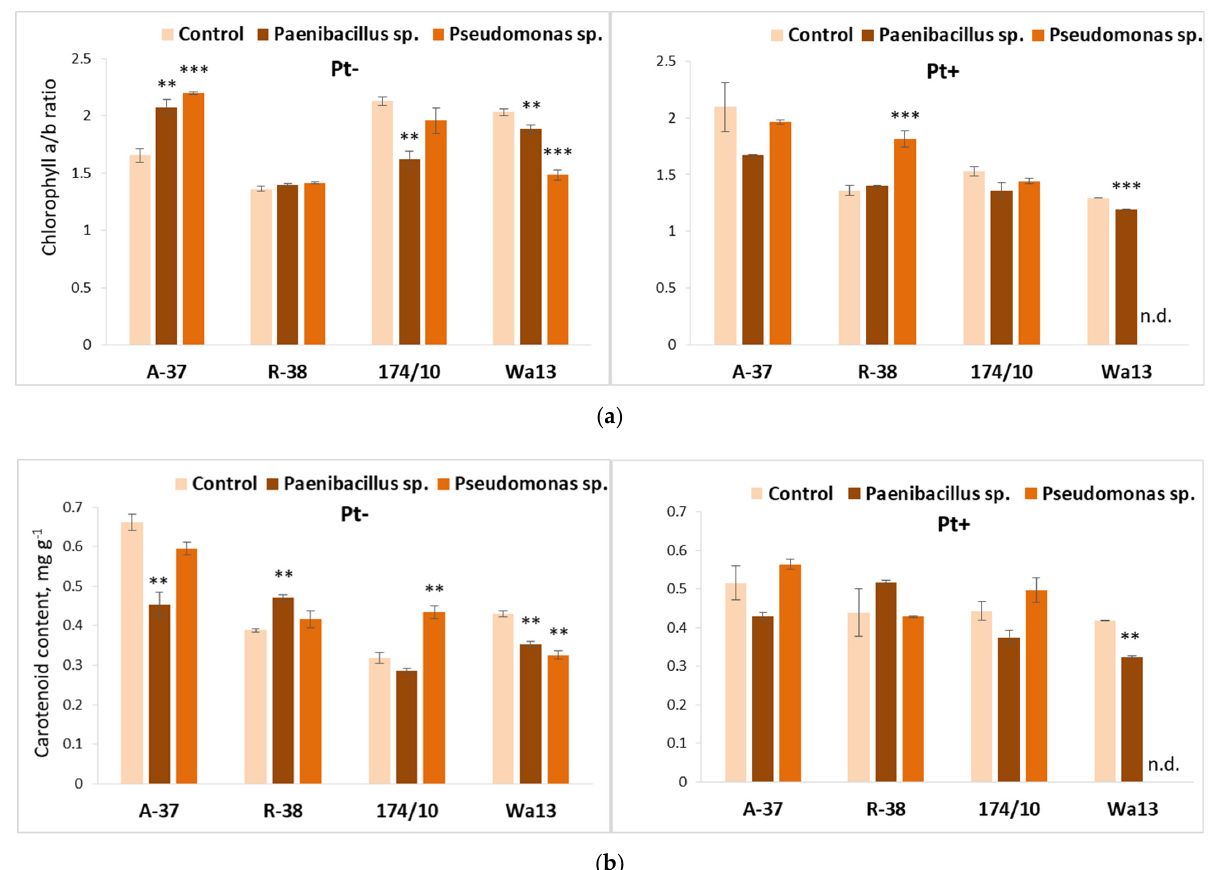
Figure 8. Average chlorophyll a/b ratio ( a ) and carotenoid content ( b ) in the leaves of different Populus genotypes (A-37 and R-38, P. tremula ; 174/10 and Wa13, P. tremula × P. tremuloides ), whose explants were first cultured on the nutrient medium inoculated with Paenibacillus sp. or Pseudomonas sp. bacteria, then transferred onto fresh nutrient medium, either sterile (‘Pt − ’) or inoculated with fungus Phellinus tremulae (‘Pt+’). Statistically significant differences from the control variant, which was not treated with bacteria during the first culture stage, are indicated (for each genotype separately): ** p < 0.01; *** p < 0.001. ‘N.d.’ means that, because of decreased explant viability, no reliable data were obtained for a particular variant.